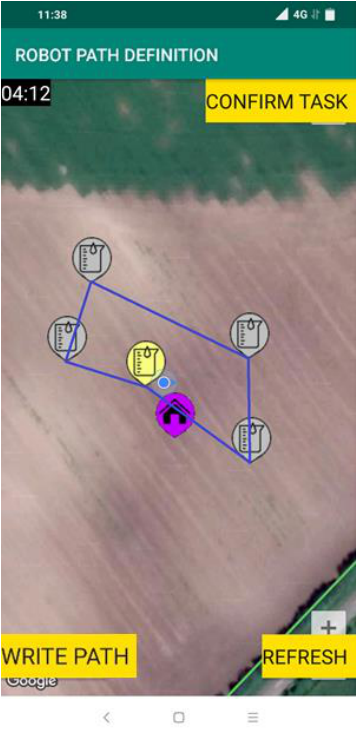
Figure 13. Google map with sampling points and optimal route.